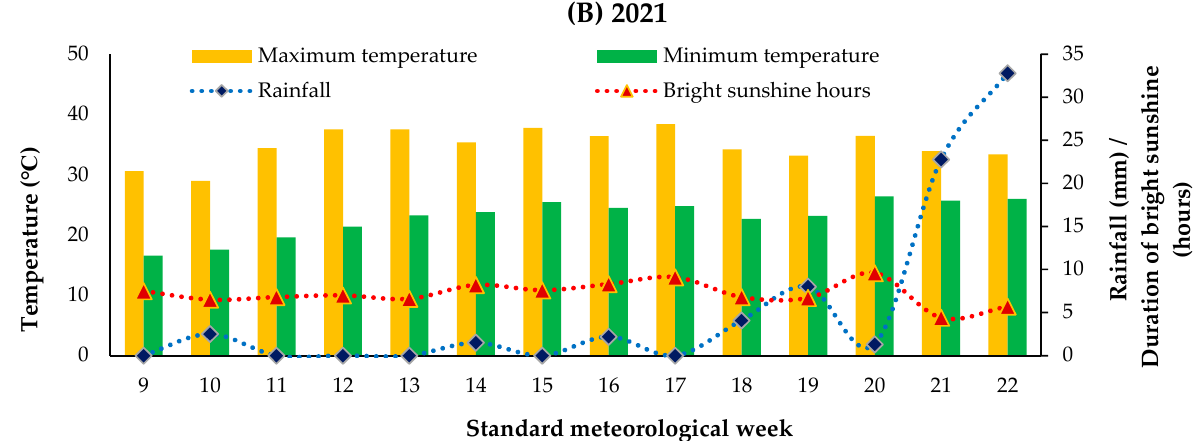
Figure 1. ( A , B ) Thermal regimes of the experimental site during the entire growing period of black gram during the spring–summer season in 2020 and 2021. Table 2. Day lengths at the experimental site during the entire growing period of black gram during the spring–summer season in 2020 and 2021.